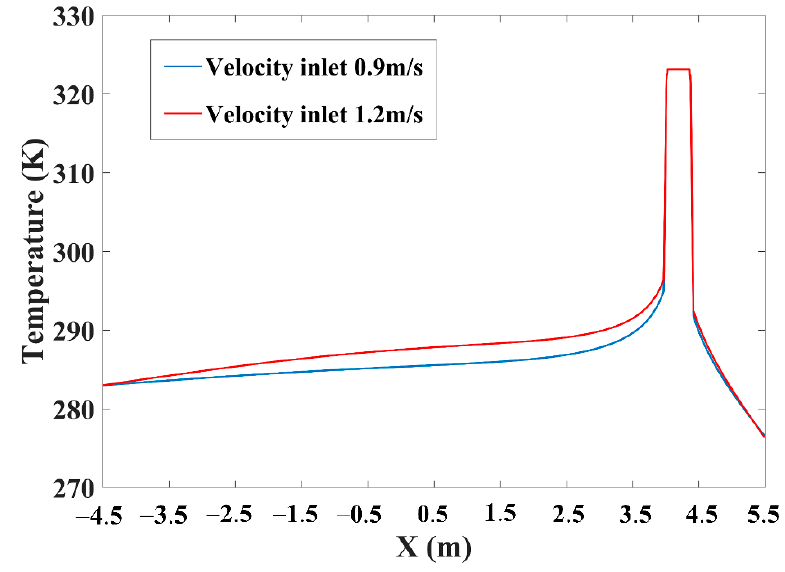
Figure 13. Temperature distribution along the centerline at different velocity.